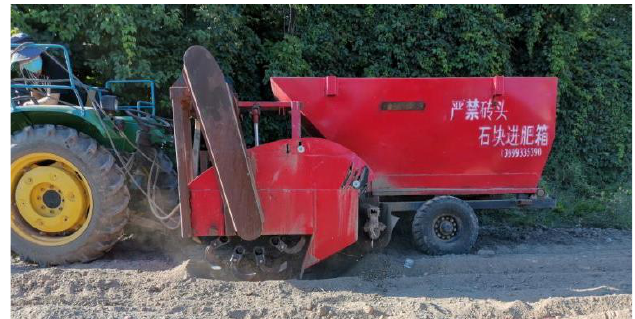
Figure 13. Soil and fertilizer mixing whole machine test.